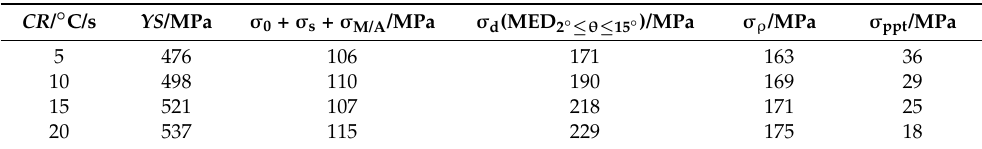
Table 4. Summary of individual strengthening contributions from different microstructural features of all steels.